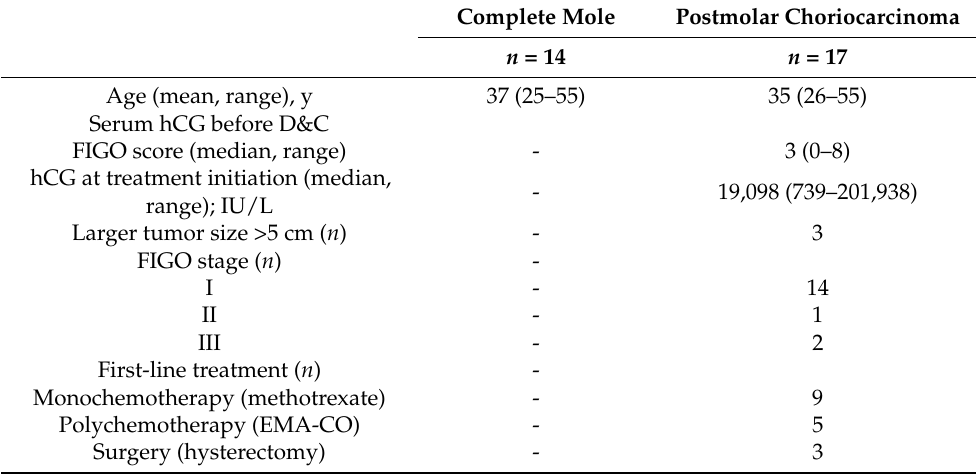
Table 1. Clinical characteristics of patients with complete mole and/or postmolar choriocarcinoma.